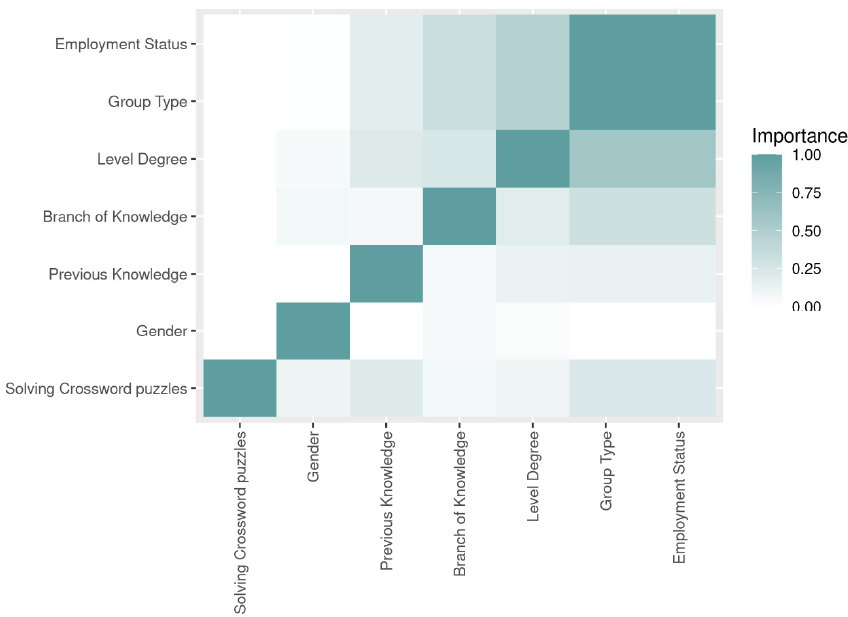
Figure 4. Relationship matrix on the selected features performed with the gain ratio